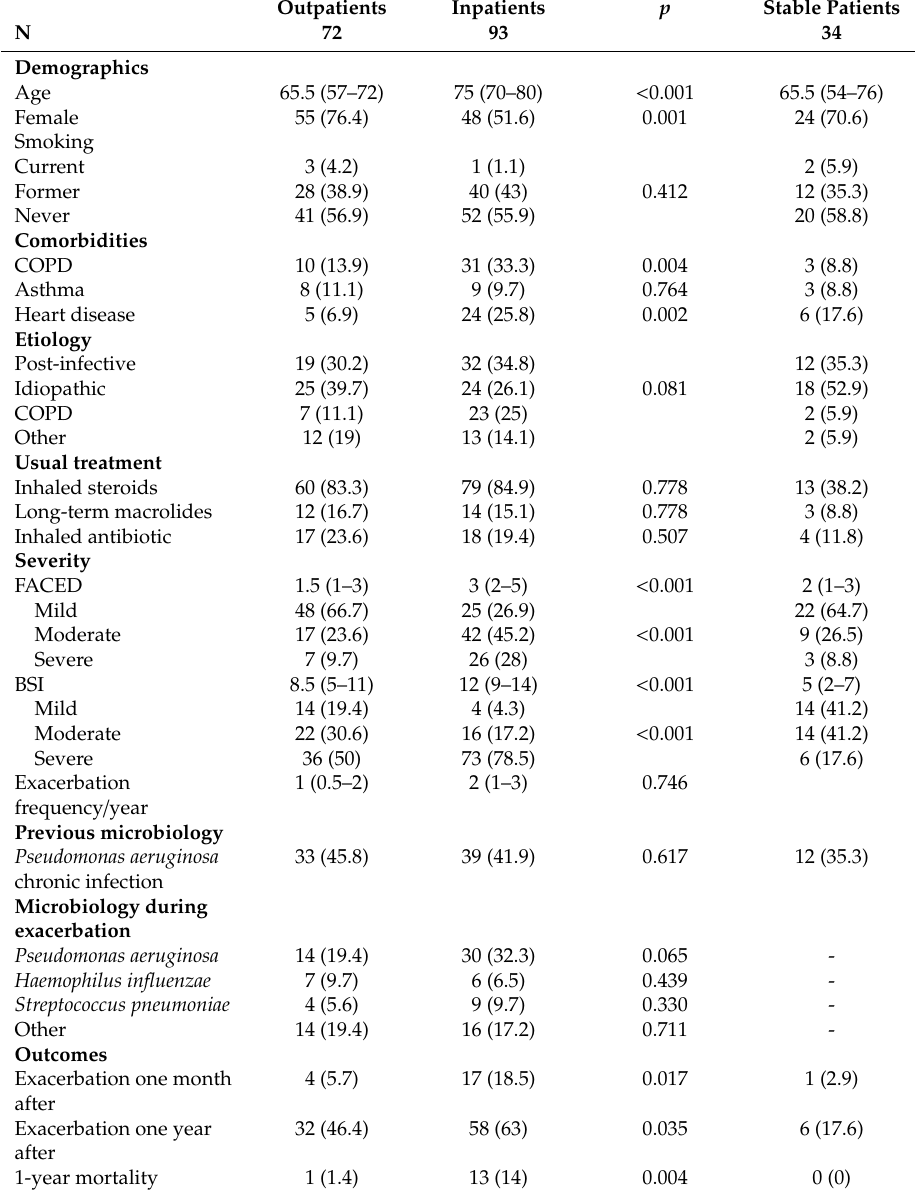
Table 2. Patients